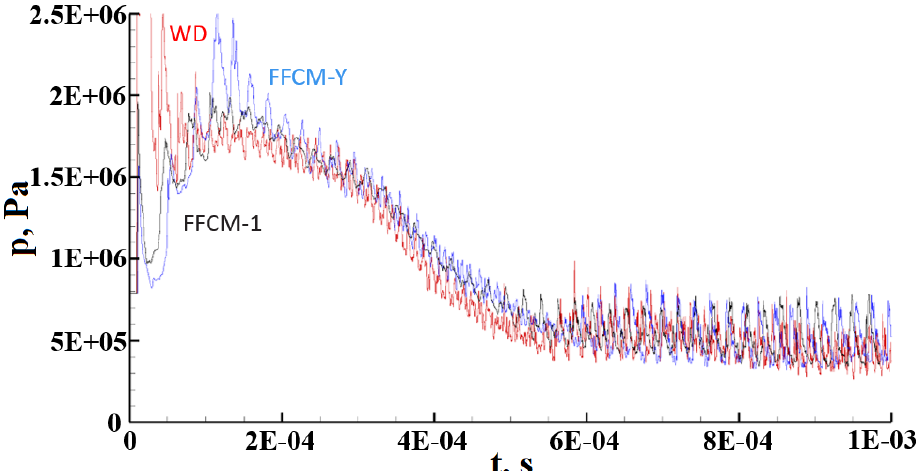
Figure 5. RDRE sector simulations CTAP pressures using chemical mechanisms: WD, FFCMy-12 and FFCM-1